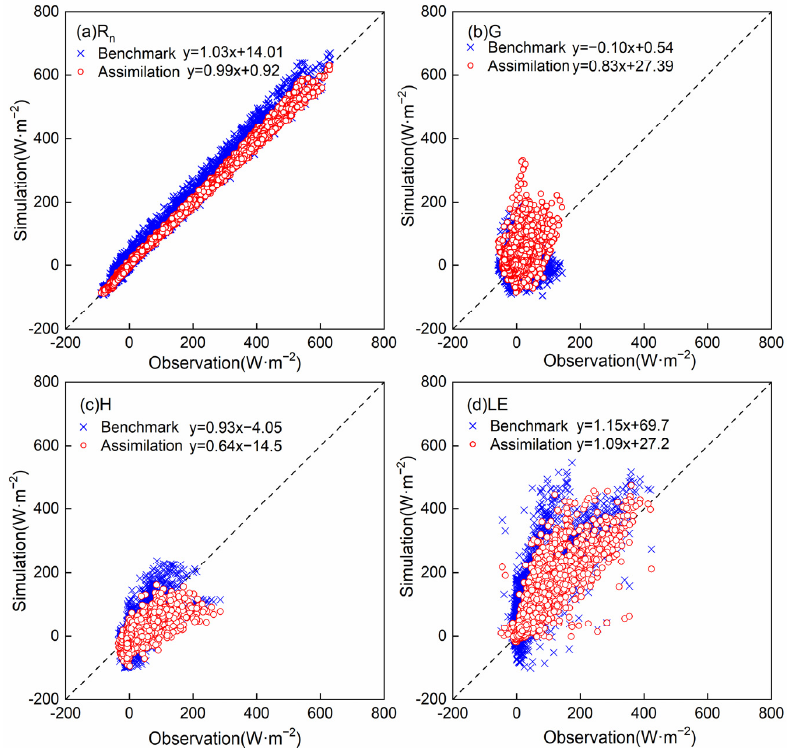
Figure 8. Scatter plots of surface flux simulation compared with observation by benchmark run and data assimilation run during maize growing season.